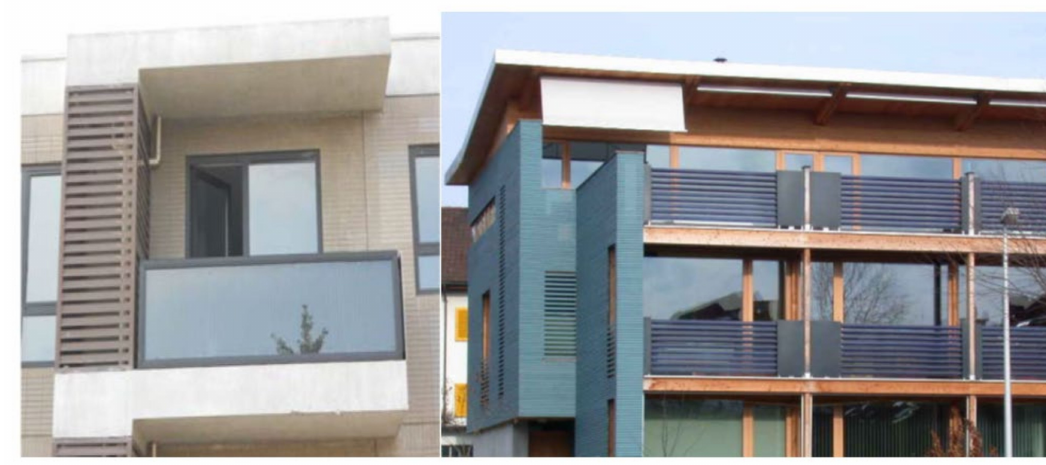
Figure 7. Glazed and evacuated tubes collectors used as balcony